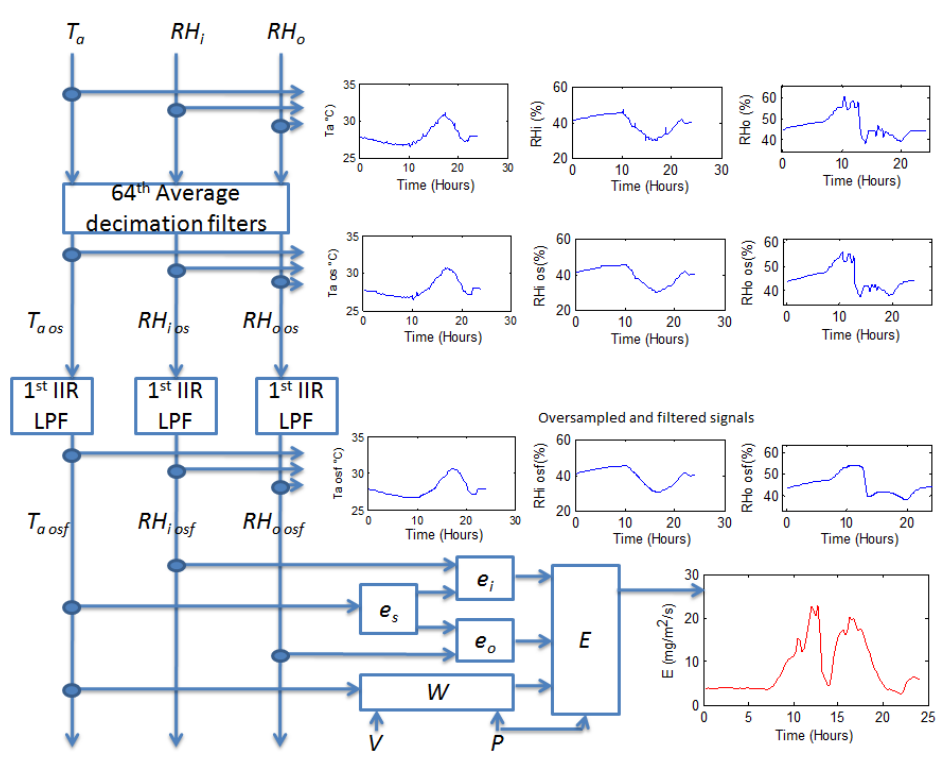
Figure 4 . Transpiration estimation signal processing methodology.